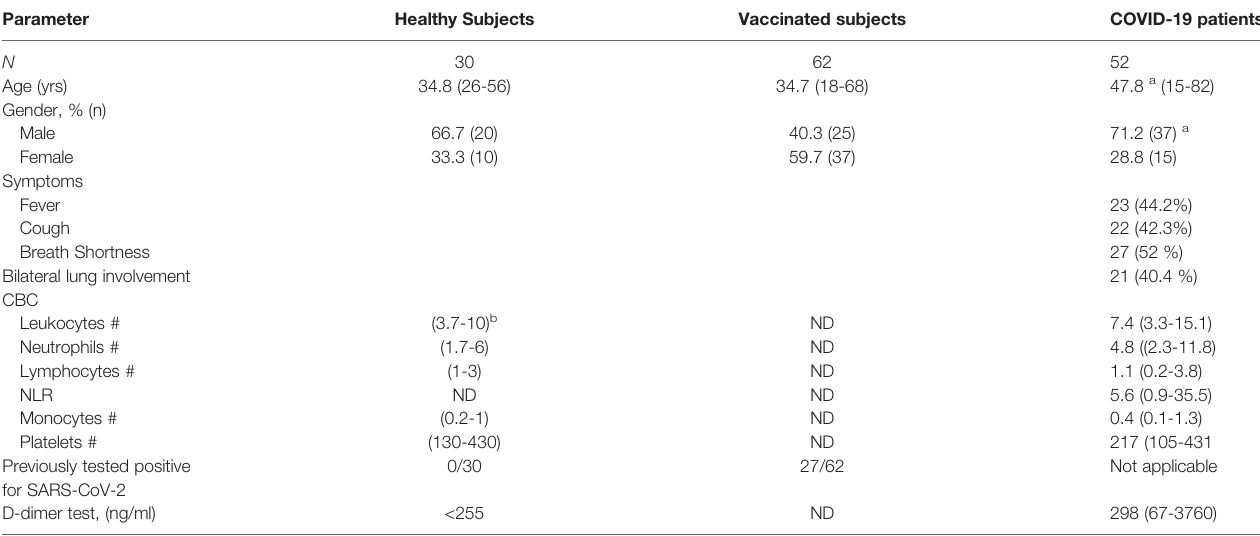
TABLE 1 | Demographics and Clinical Characteristics of study populations.